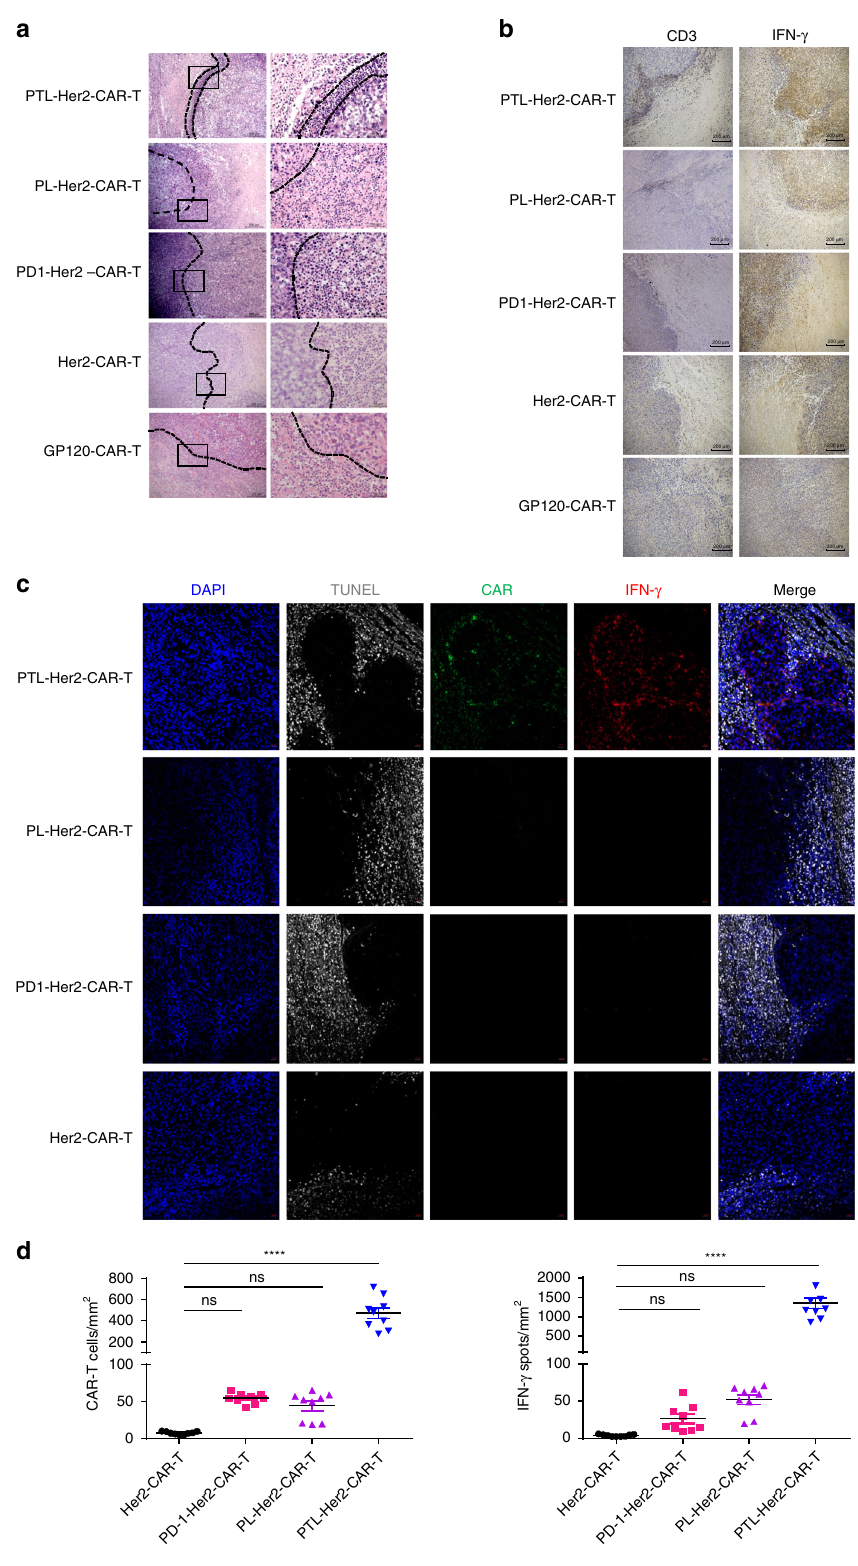
and the control GP120-CAR-T cells were also introduced in our experiment. Human CD8 + T cells were highly accumulated in the spleen of mice treated with PTL-Her2-CAR-T cells compared with those in the control CAR-T cells (Supplementary Fig. 7a).